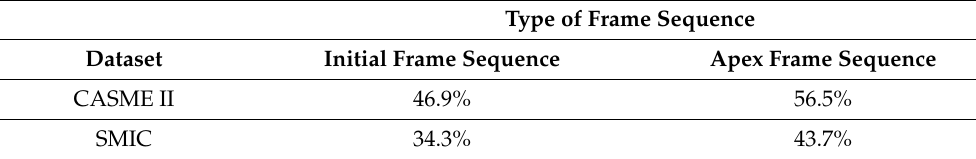
Table 3. Performance of Model-A using initial frames and the Apex frame